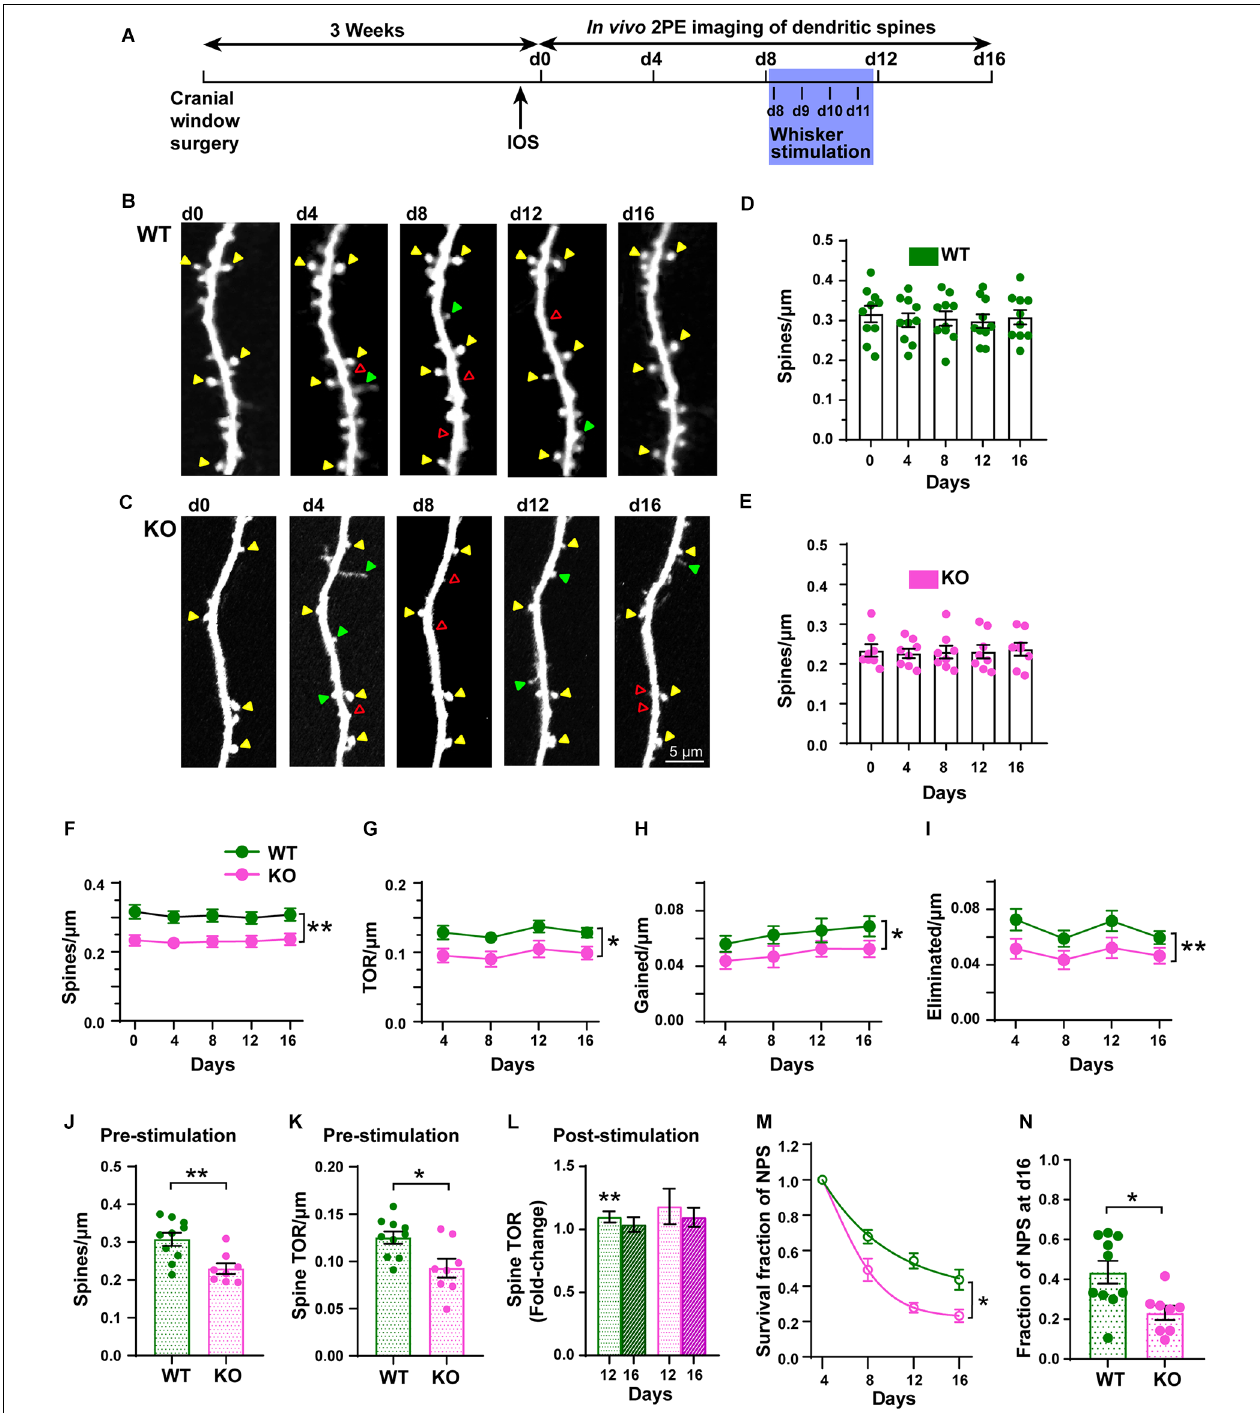
FIGURE 6 | Chronic in vivo quantification of density and dynamics of dendritic spines of L5 pyramidal neurons in S1BF. (A) Experimental timeline with imaging intervals of 4 days over 16 days (d0 to d16). Whisker stimulation occurred daily from d8 (following 2P imaging) until d11. IOS: Intrinsic Optical Signal imaging. (B,C) Representative high-resolution images of dendritic segments from the apical tuft of layer 5 pyramidal neurons in WT and KO mice acquired using in vivo 2PE microscopy. (D,E) Density of dendritic spines in WT and KO mice. (F–I) Changes in spine density, TOR/ µ m, gained/ µ m, and eliminated/ µ m at 4-day intervals in WT and KO mice. (J,K) Pre-stimulation dendritic spine density and TOR ratios. (L) Post-stimulation (pre-stim. vs. d12 and d16) fold-change of TOR. (M) Survival function of new persistent spines (NPS) formed at d4. (N) Fraction of NPS at d16. Arrowheads indicate persistent (yellow), gained (green), and eliminated (red) spines. * p < 0.05; ** p <